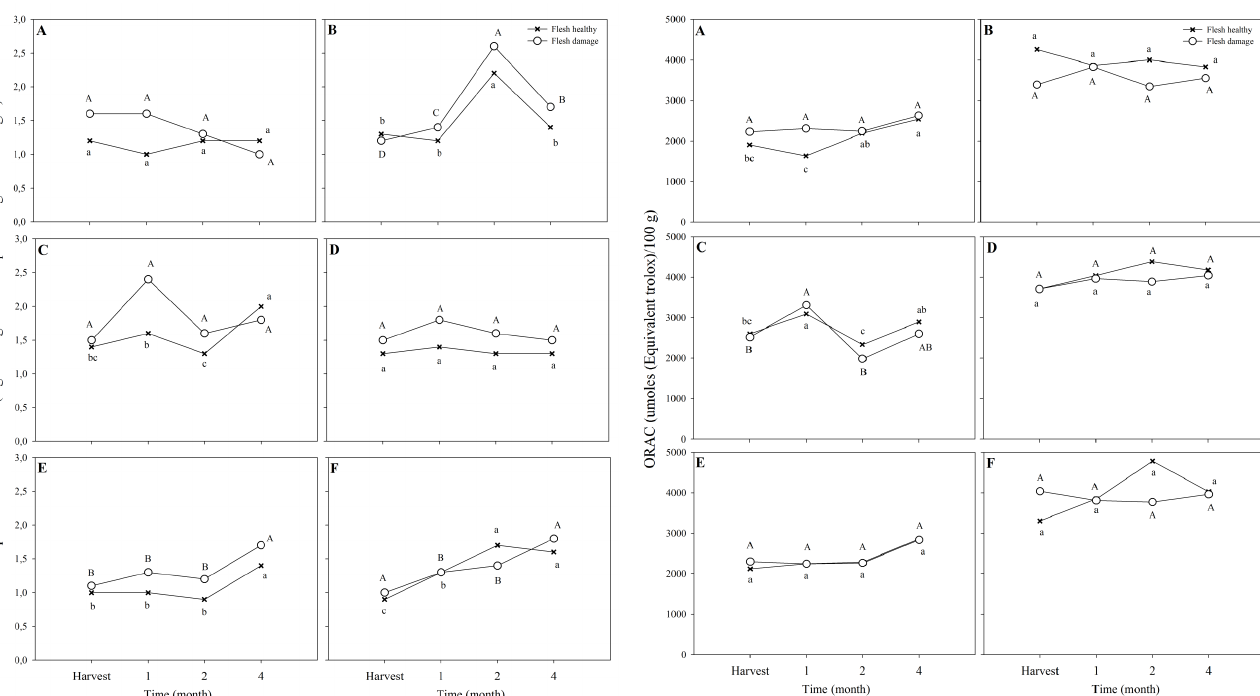
Fig. 4: Evolution of Total Phenols in apple flesh from cv. Brookfield® (A and B), Granny Smith (C and D) and Fuji (E and F), from harvest to 4 months of cold storage from conventional (A, C and E) and or- ganic (B, D and F) orchard, in healthy and sun-burned apple.